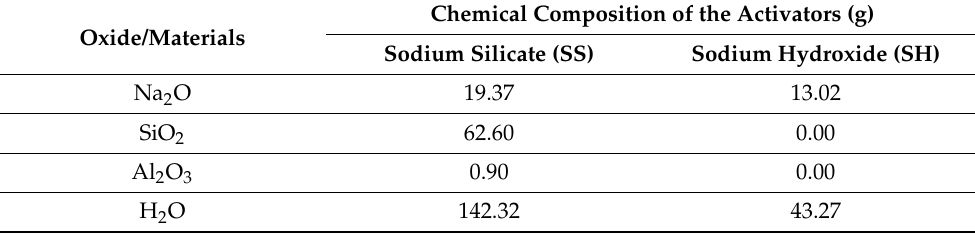
Table 2. Chemical composition of the activators.